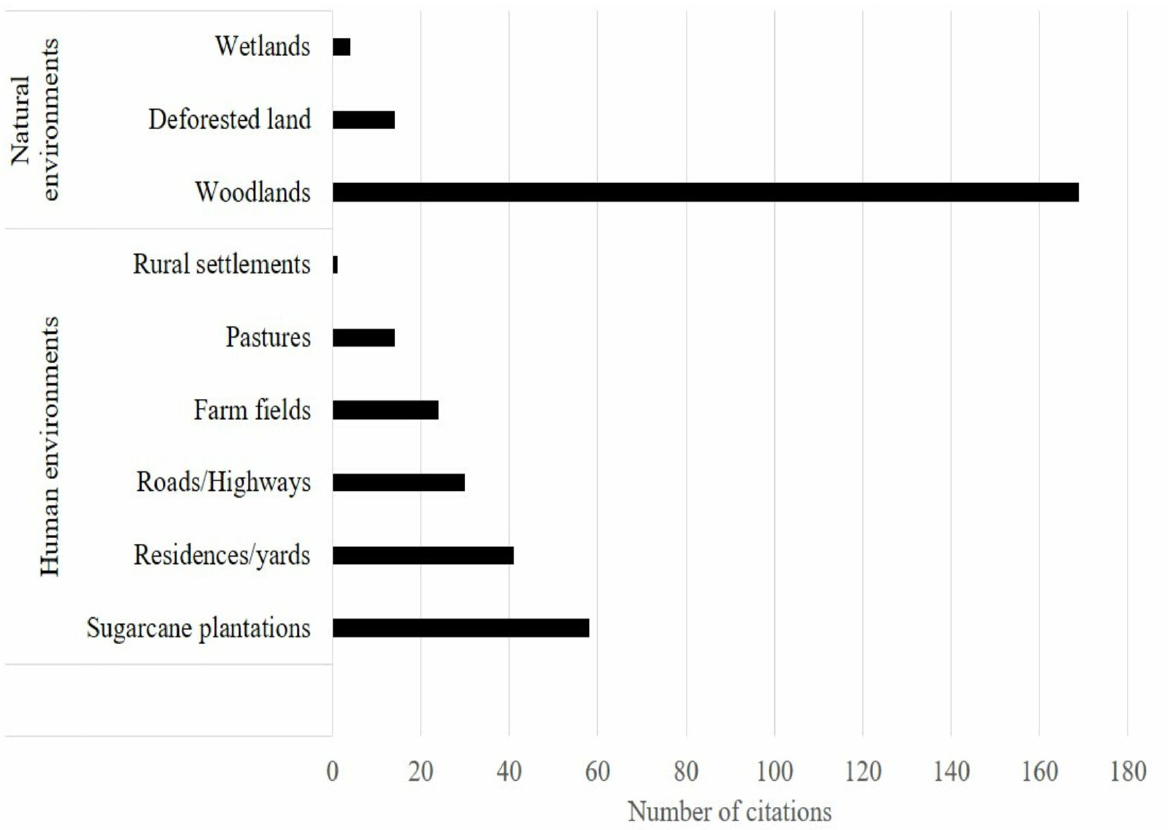
Figure 2. Environments related to the presence of C. thous cited by